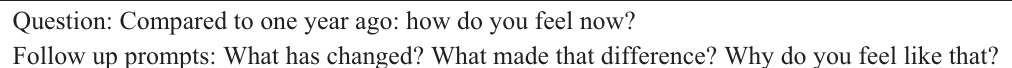
Table 1. A sample